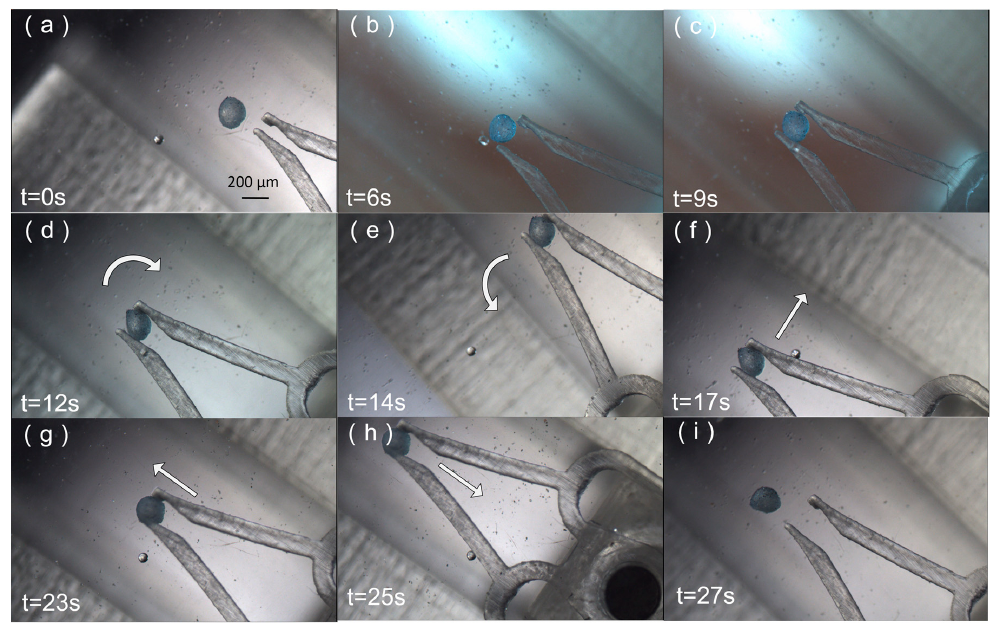
Figure 8. The microgripper grasping and carrying a microparticle. ( a ) The microgripper is in its original state. ( b ) The microgripper ready to be opened. ( c ) The gripper open under action of a magnetic force applied to the gripper. ( d ) The robot is rotated clockwise, carrying the particle. ( e ) The microgripper rotates counter-clockwise. ( f – i ) The microgripper carries the micro-particle along a straight line and release the microparticle. Micromachines 2018 , 9 , x FOR PEER REVIEW